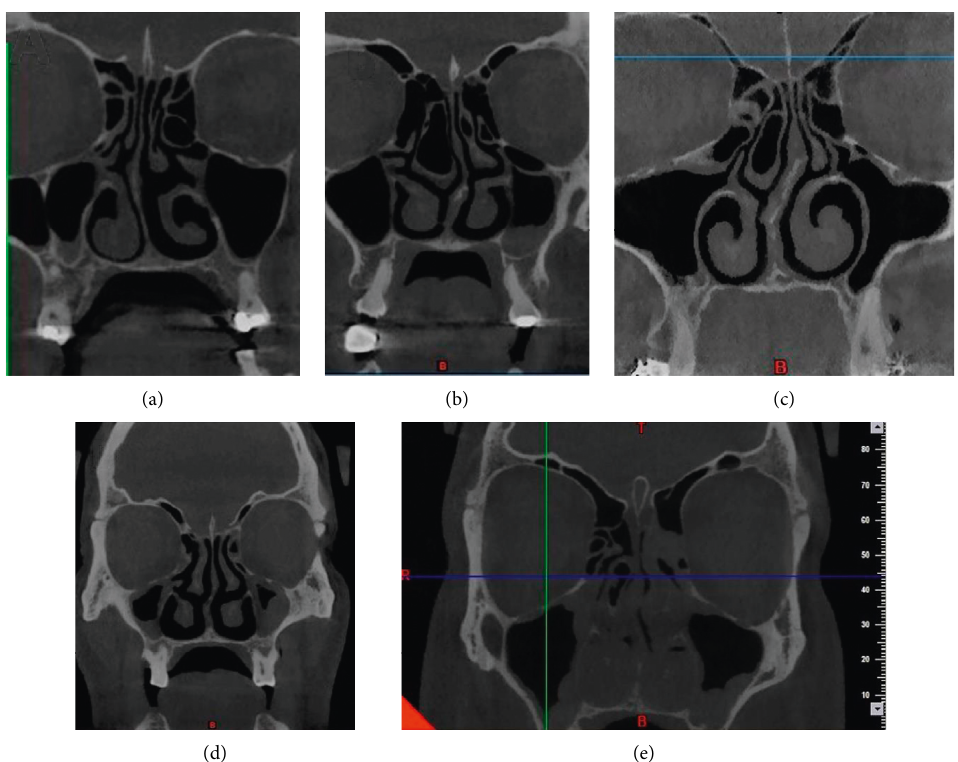
Figure 1: Types of septal deviation: (a) C-shaped in the coronal plane, (b) reverse C-shaped in the coronal plane, (c) reverse S-shaped in the coronal plane, (d) reverse S-shaped in the coronal plane, and (e) S-shaped in the coronal